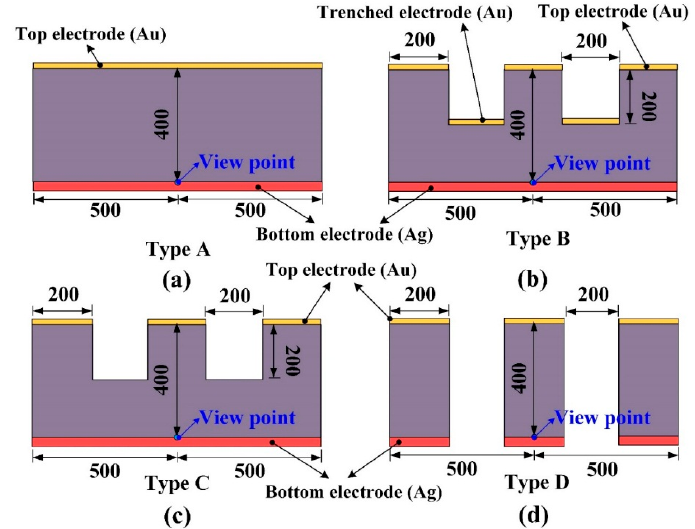
Figure 7. Points defined in the PZT cells with various structures (Types A to D) (unit: µ m). ( a ) Type A; ( b ) Type B; ( c ) Type C; ( d ) Type D.